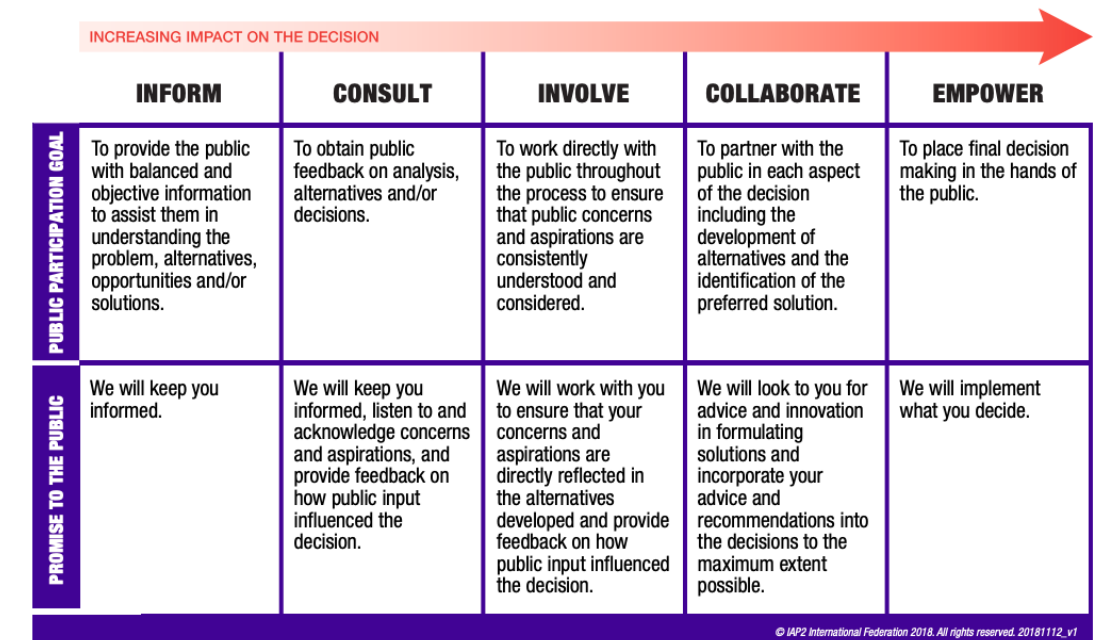
Figure 2. Spectrum of public participation (IAP2,